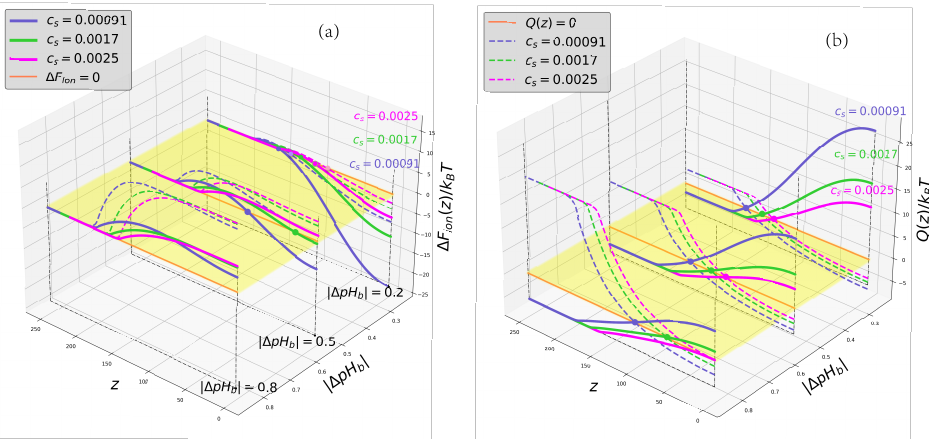
Figure 4. Cross-sections of the 2D profiles of the insertion free energy ∆ F ion ( z , | ∆ pH b | ) ( a ) and BSA globule charge Q ( z , | ∆ pH b | ) ( b ) for the cases of polyanionic (solid curves, pH b > pI ) and polycationic (dashed curves, pH b < pI ) brushes. The color code corresponding to different salt concentrations C s is indicated at the curves. Colored circles in the panel correspond to the charge inversion points z = z ∗